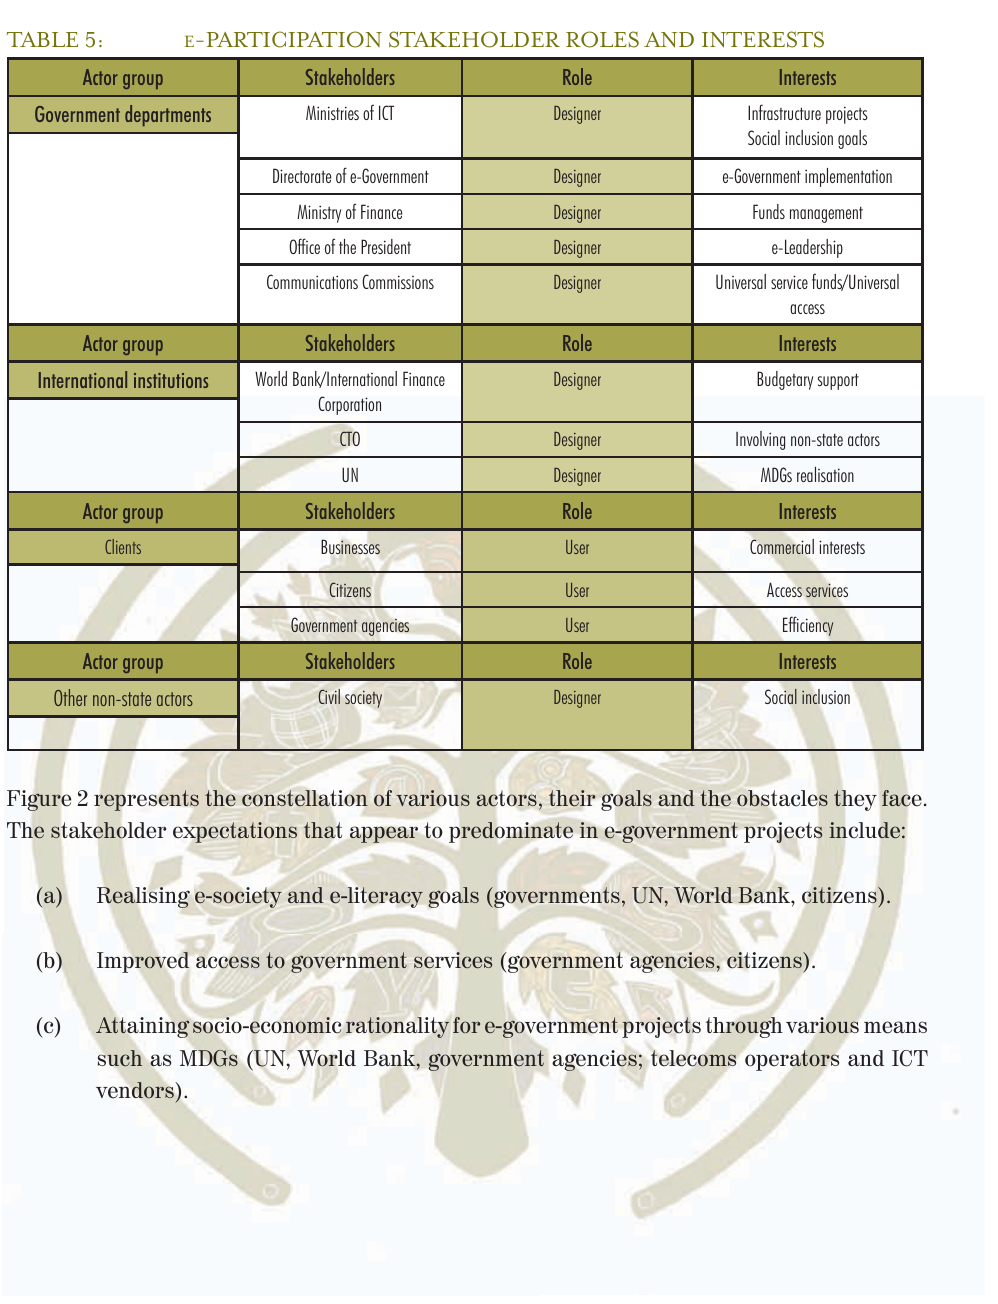
Figure 2 represents the constellation of various actors, their goals and the obstacles they face. The stakeholder expectations that appear to predominate in e-government projects